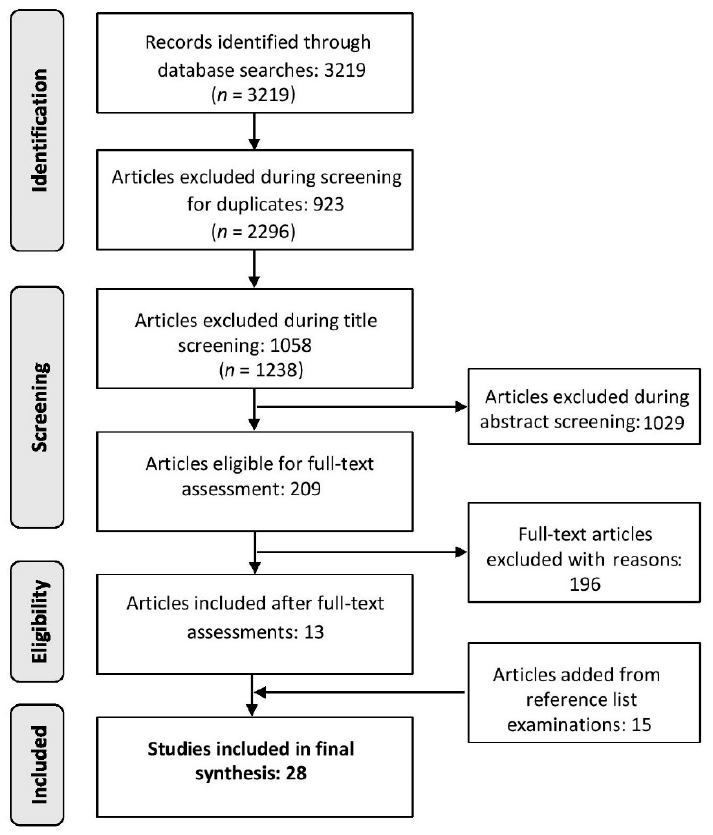
Figure 1. Study selection chart.